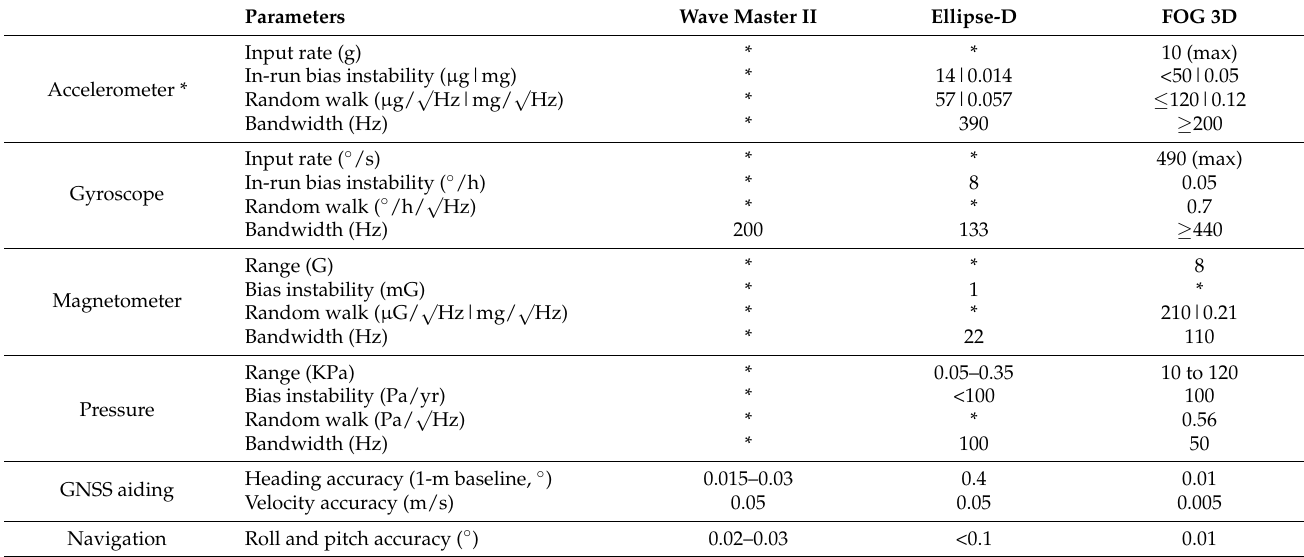
Table 3. Systems’ specifications overview as provided in the manufacturer’s